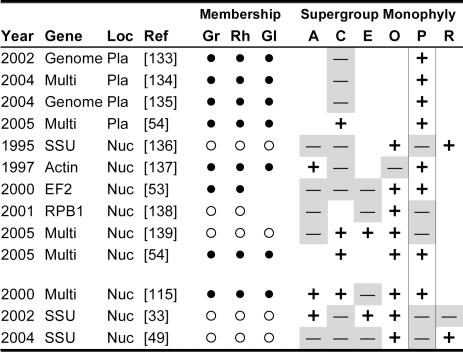
Support for Membership and Supergroup Monophyly from “Plantae”-Targeted Molecular GenealogiesMember taxa: Gr, Chloroplastida = Viridiplantae (Green algae, including land plants); Rd, Rhodophyceae (Red algae); Gl, Glaucophyta. See Figure 4 for general notes and Figure 5 for plastid-specific notes. References cited in this figure are [33,49,53,54,115,133–139].